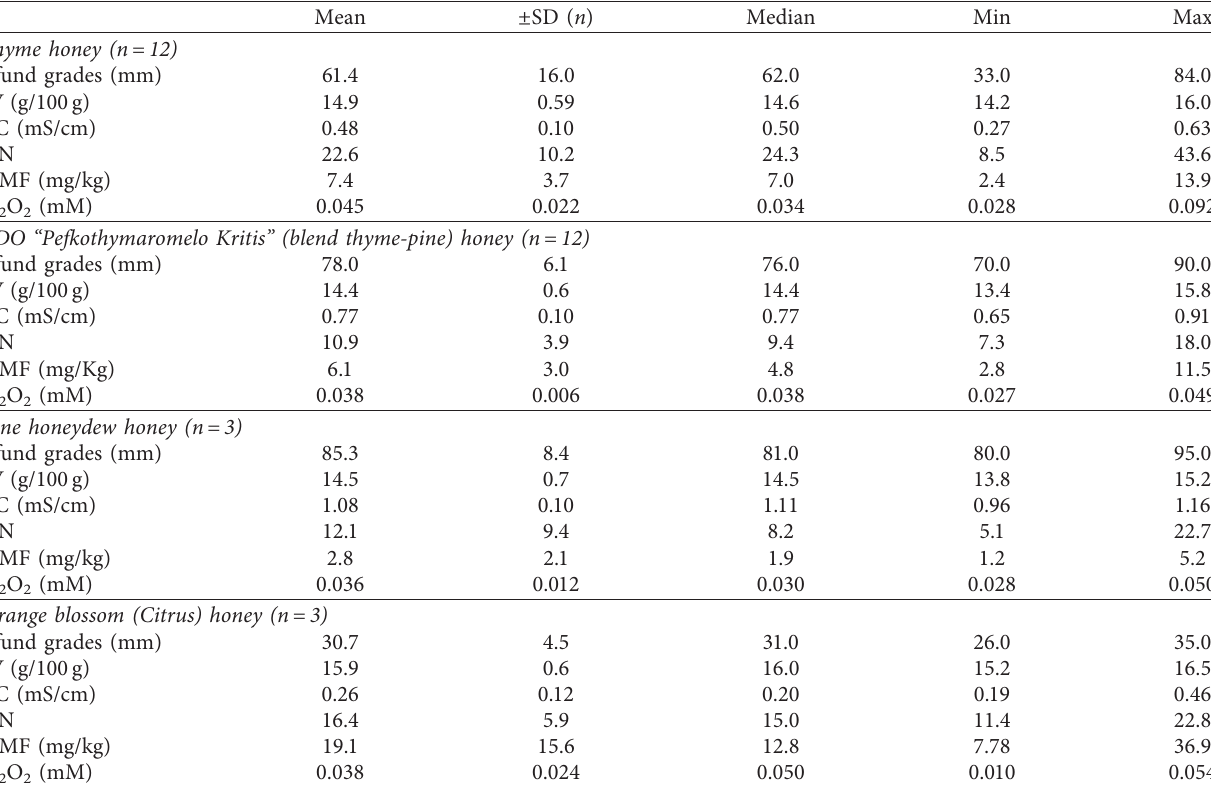
Table 2: Variation of color (Pfund grades), moisture content ( W ), electrical conductivity (EC), diastase activity (DN), hydrox-